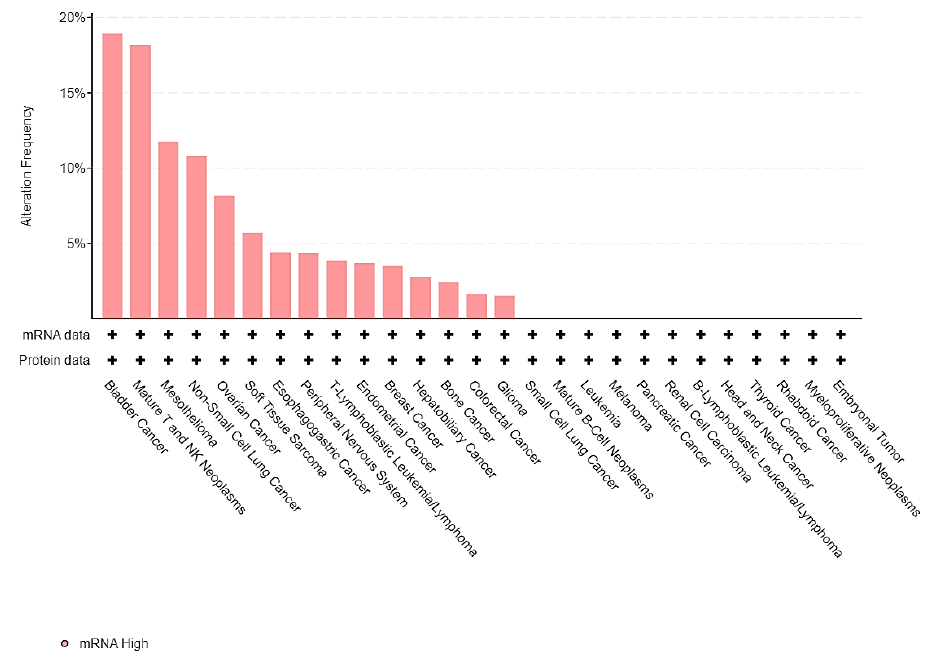
Figure 1. Barplot of EPAS1 expression across different cell lines from the Cancer Cell Line Encyclope- dia (CCLE).